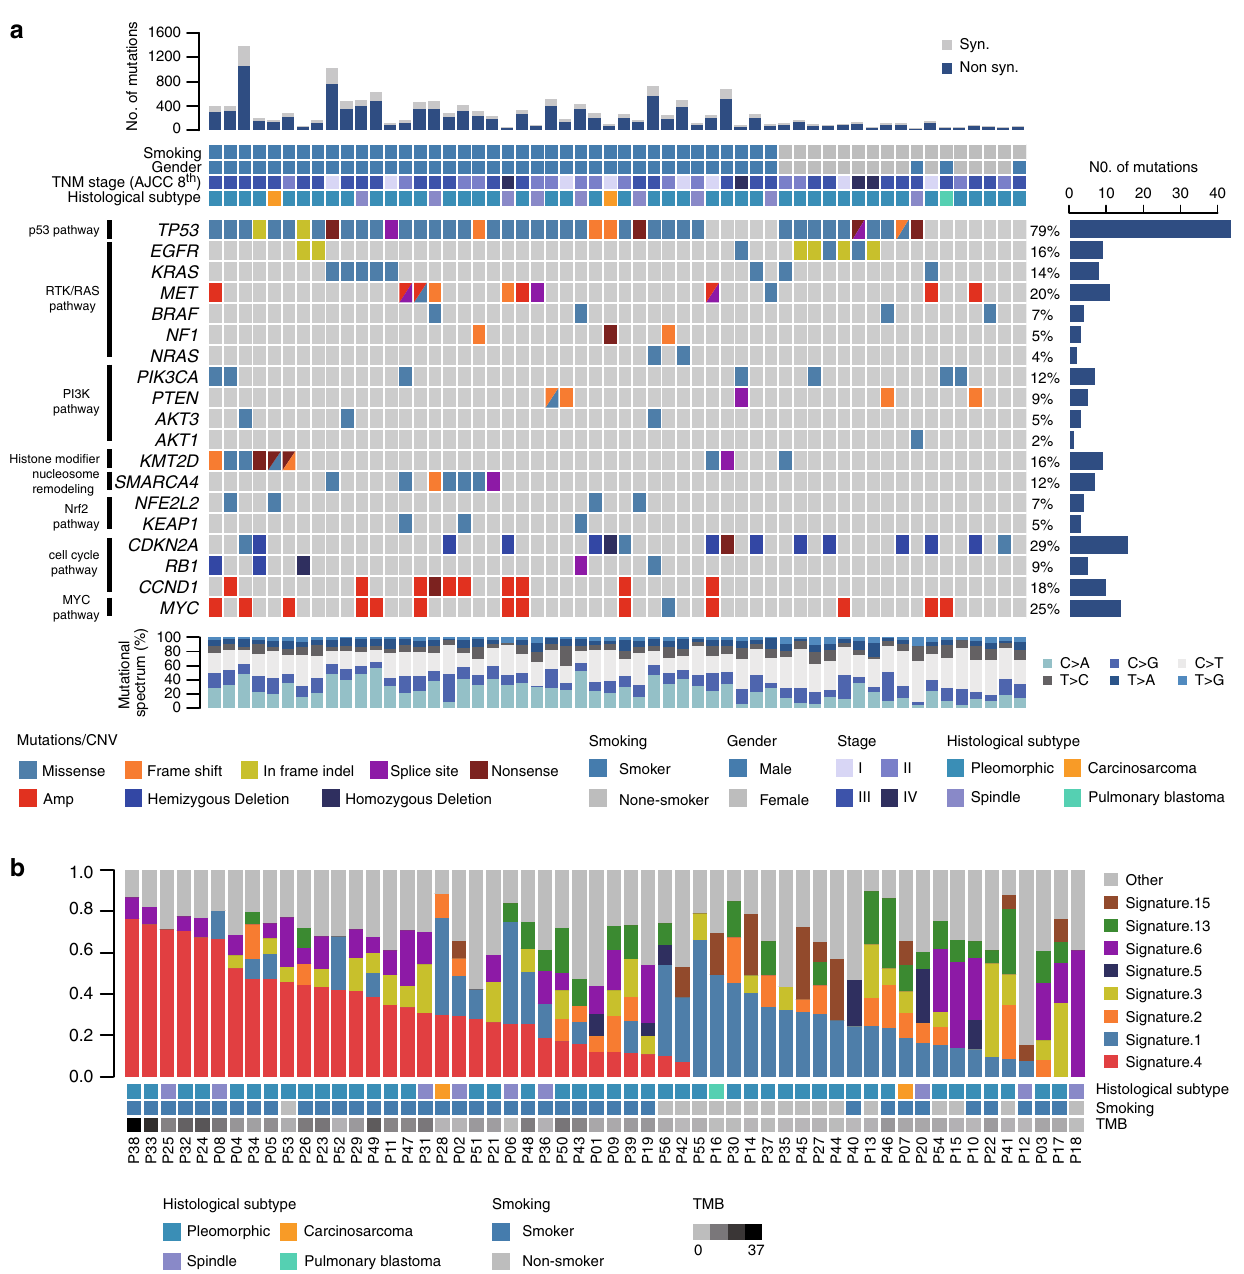
Fig. 1 Genomic alterations in pulmonary sarcomatoid carcinoma (PSC). a Spectrum of the key molecular alterations in PSC. The genomic alterations of smokers and nonsmokers are demonstrated in the left and right side, respectively. The overall number of somatic mutations and clinicopathological data are shown at the top. The type of base-pair substitutions of each sample are displayed in the bottom panel. b Mutational signatures in our cohort ( n = 56). Samples, annotated for the histological subtype, smoking status and tumor mutation burden, are ordered by the contribution of signature 4. Source data are provided as a Source data fi